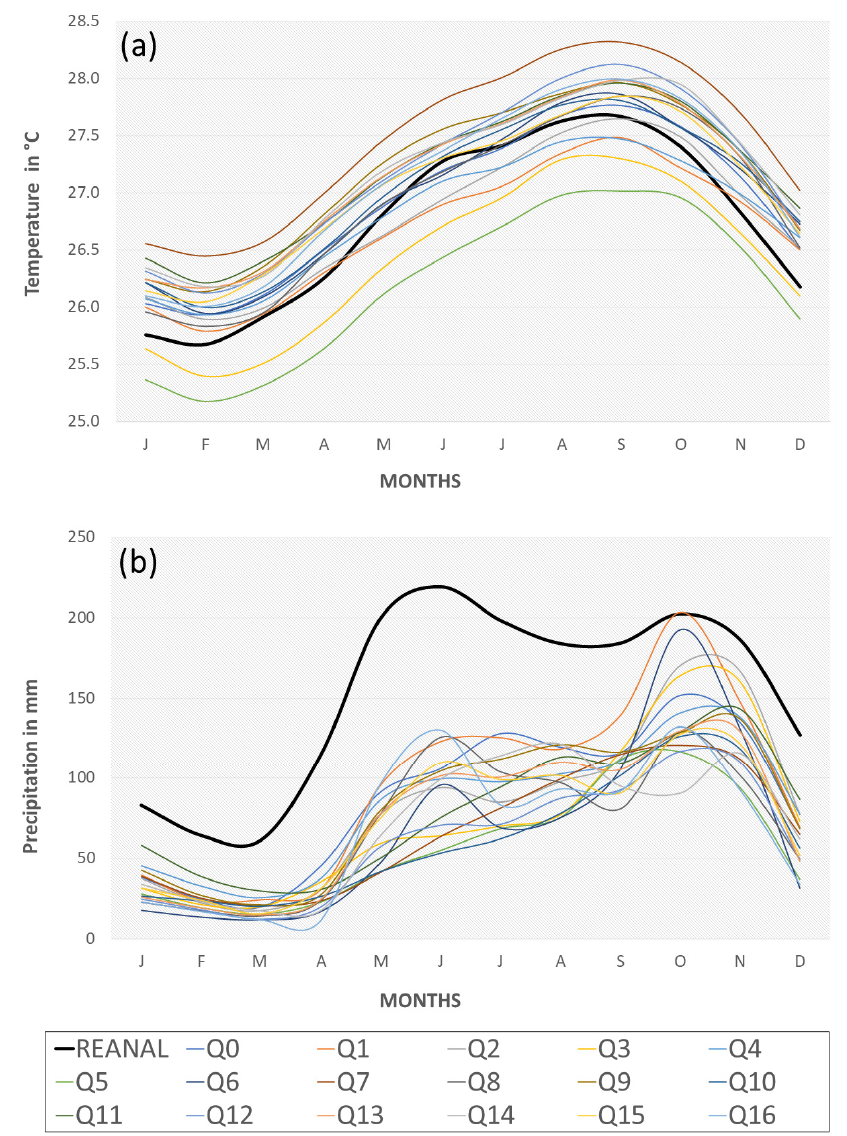
Figure 3. ( a ) Temperature and ( b ) rainfall climatologies for each ensemble member and reanalysis. Averaging is over the domain shown in Figure 2 and the period 1960–1990.